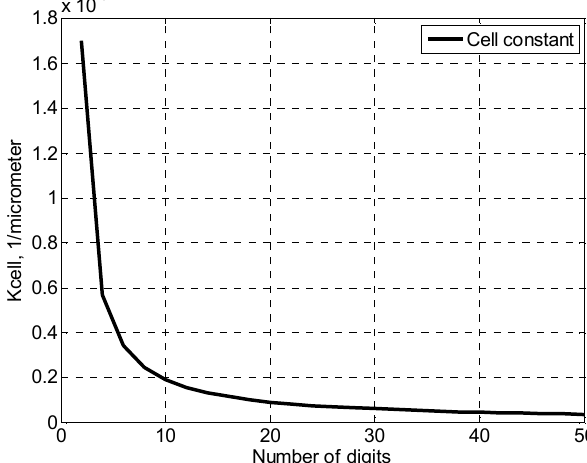
Fig. 4: Analytical optimization of the dimensional parameters that to say width W and spacing S. The geometrical term Y (a) is a function of S and W, where the ratio a is equal to S/W. Its value of optimization is 0.66.